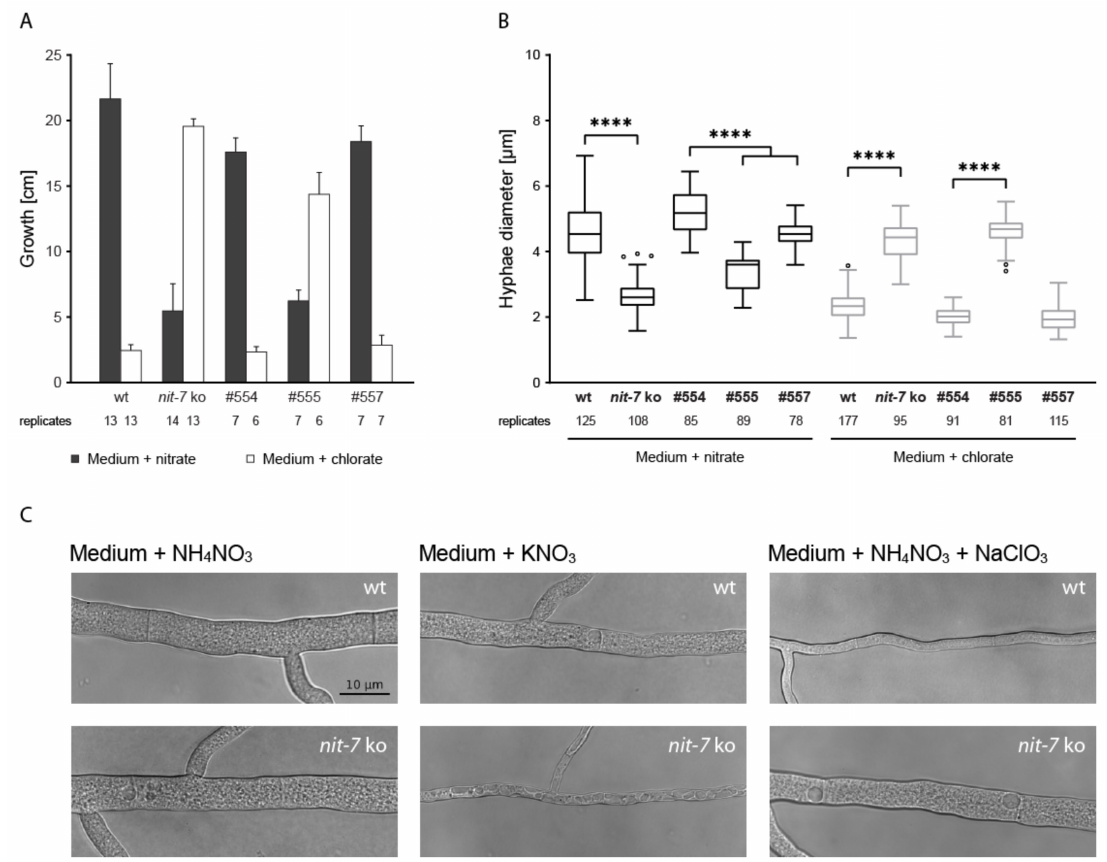
Figure 5. Quantification of the Neurospora crassa nit -phenotype. ( A ) Nitrate-dependent growth (i.e., growth under nitrogen-derepressing and nitrate-inducing conditions = nitrate medium) of indicated N. crassa strains, see Table 1, wt = wild type. In the complementary experimental setup, growth was quantified on medium containing chlorate. ( B ) The hyphal diameter of the strains analyzed in (A) has been determined and is shown as Tukey´s box blots. Multiple comparisons analysis was carried out using ordinary one-way ANOVA (Tukey´s method) with **** p ≤ 0.001. ( C ) Representative images of hyphae from strains assayed in (A + B) on di ff erent